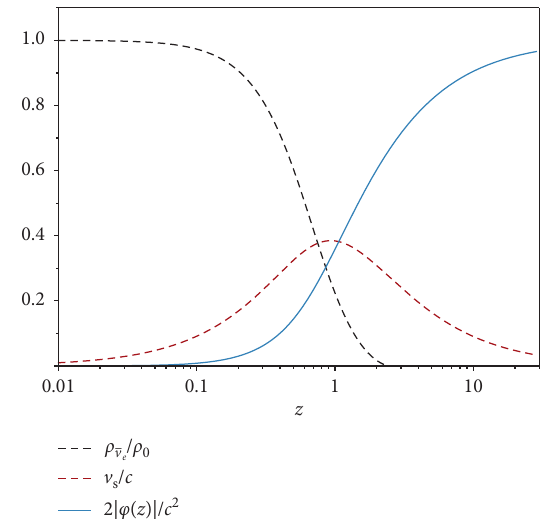
Figure 3: Density-redshift profile, and relative contributions to the redshift by gravitational potential and radial velocity. In the ATLAS model, redshifts at low- z are mainly due to radial velocity (dashed curve) and at high- z due to time dilation of free-falling sources in the gravitational potential φ (solid curve). The density (dotted curve) acts as a form of dark energy density and vanishes at the antineutrino star’s radius, R � 21.1Gly (or z � 2.49). This plot is based on calculations using the best-fit parameters found in the following